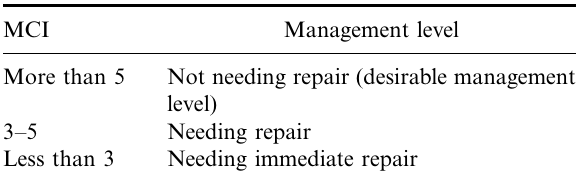
Table 2. The dependence of maintenance levels on the